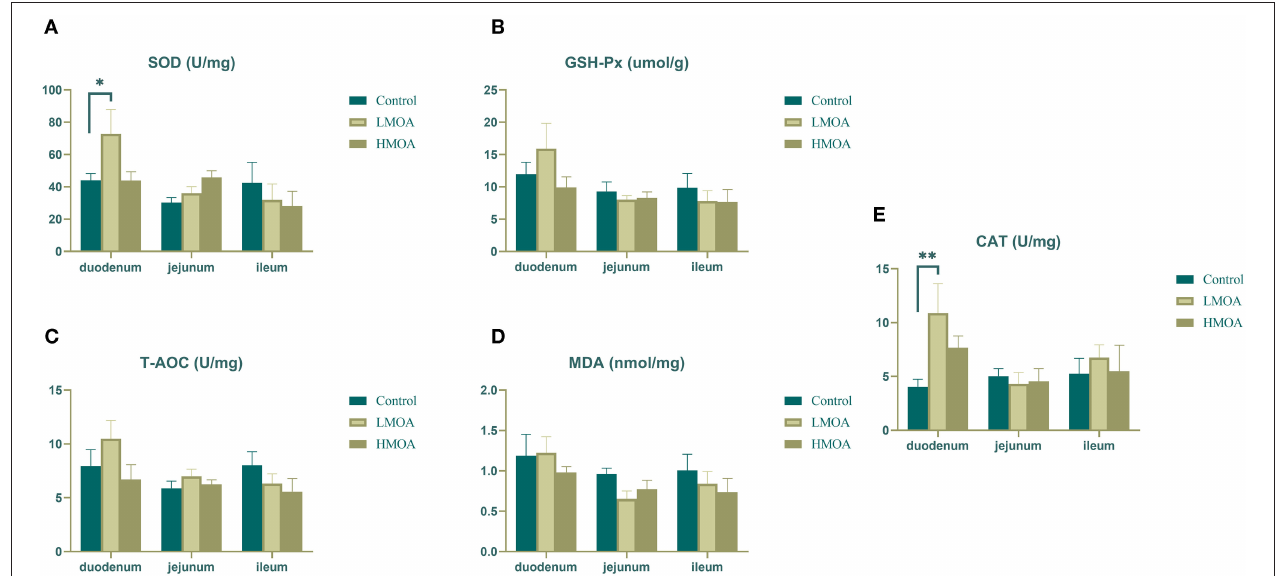
FIGURE 2 | The antioxidant enzyme characteristics of small intestine in 42 d-broilers as affected by dietary MOA supplementation. (A) Superoxide dismutase activity (SOD), (B) Glutathione peroxidase activity (GSH-Px), (C) Total antioxidant capacity (T-AOC), (D) Malondialdehyde (MDA), (E) Catalase activity (CAT). Control: a basal diet of corn-soybean meal with 0 mg/kg of mixed organic acid; LMOA: a basal diet with 3,000 mg/kg of mixed organic acids; HMOA: a basal diet with 6,000 mg/kg of mixed organic acids. Data are indicated as means ± SEM ( n = 8). Bar with the asterisk (*) level presented the degree of significant difference. * 0.01 < p < 0.05; ** 0.001 < p < 0.01.